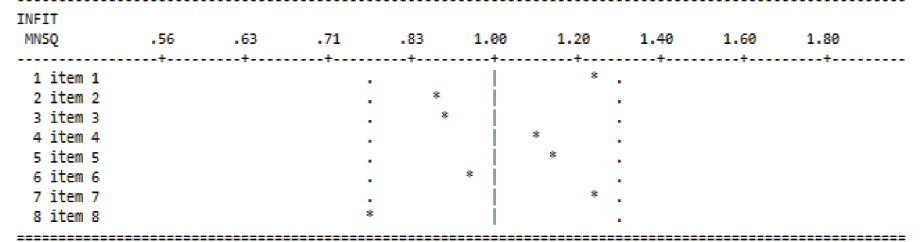
Figure 3. Results of the analysis of critical thinking from infit mean square